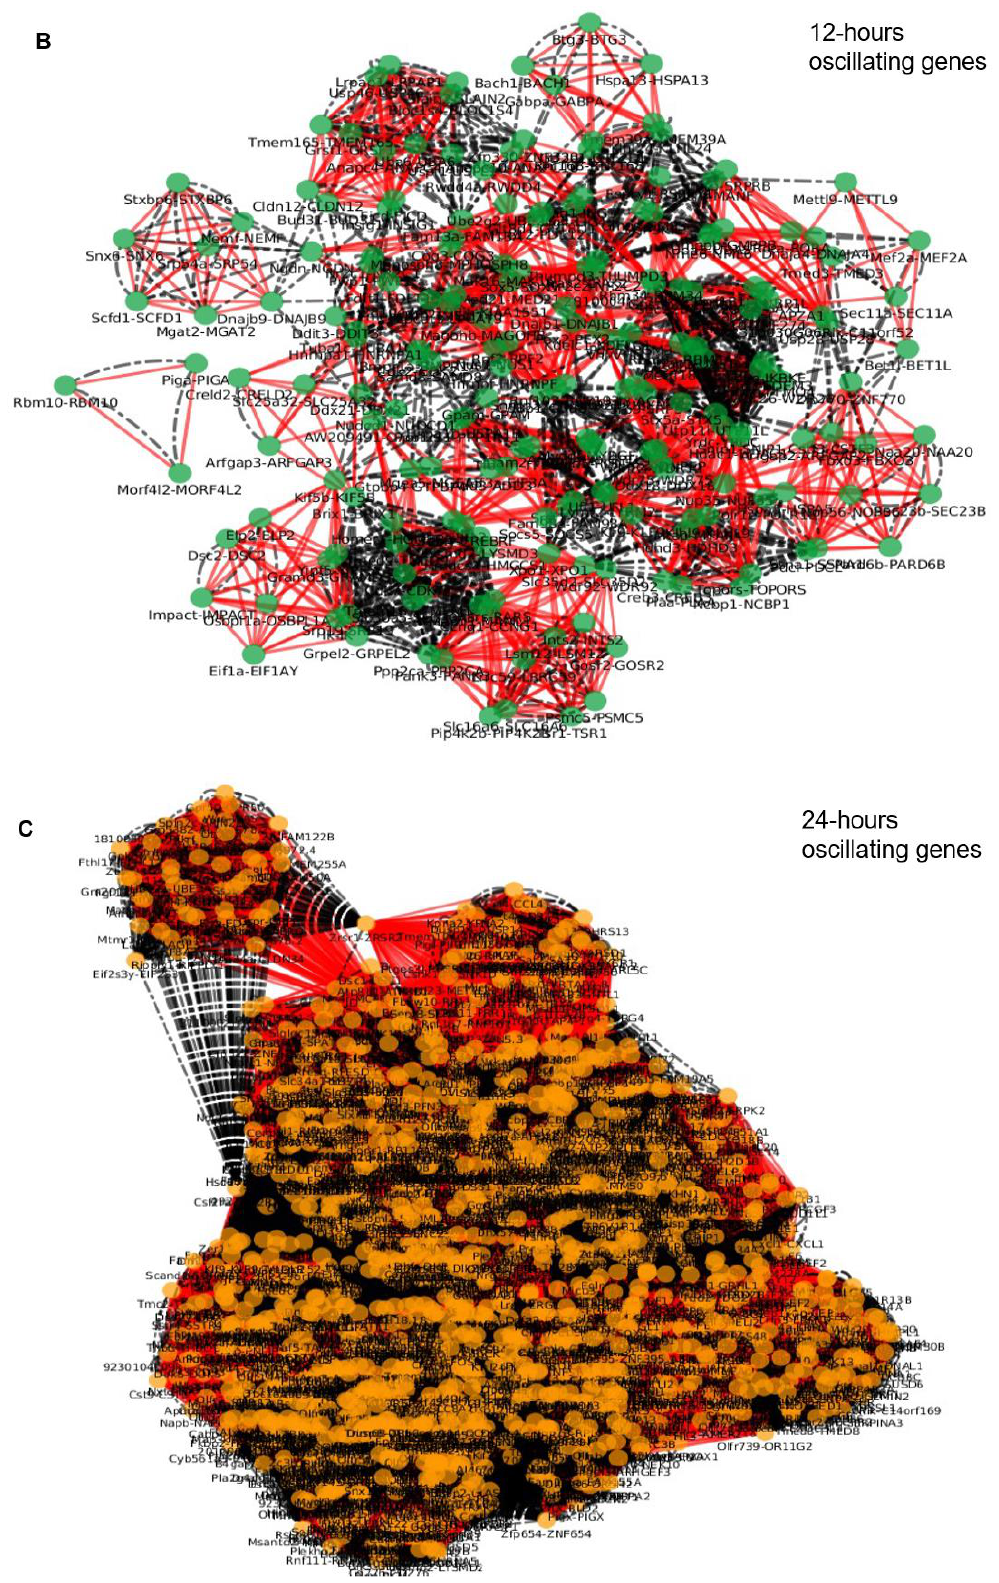
Figure 4. Chromosome mapping with genomic clustering of oscillatory genes in M. musculus and H. sapiens chromosomes for ( A ) 8-h, ( B ) 12-h and ( C ) 24-h oscillating genes (the cytoscape files are provided as Figure S7.